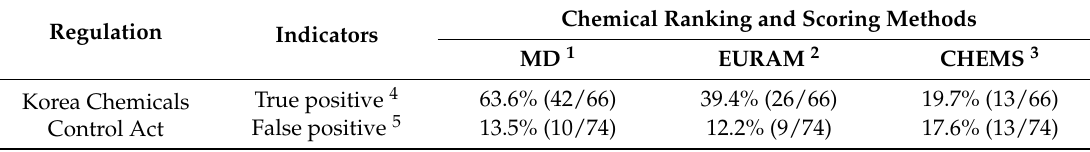
Table 8. The proportion of chemicals selected as highly hazardous in each method that were included in the chemical list of the Korea Chemicals Control